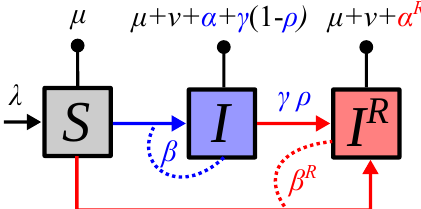
Figure 1 – Epidemiological model flow diagram. Drug-resistant infections (in red) can originate from direct transmission or treatment failure in drug-sensitive infections (in blue). Dashed lines show infection events, arrows transition between states and lines with a circle death or recovery events. Individuals who die or recover from the infection are removed from the system. Parameter notations are detailed in Table